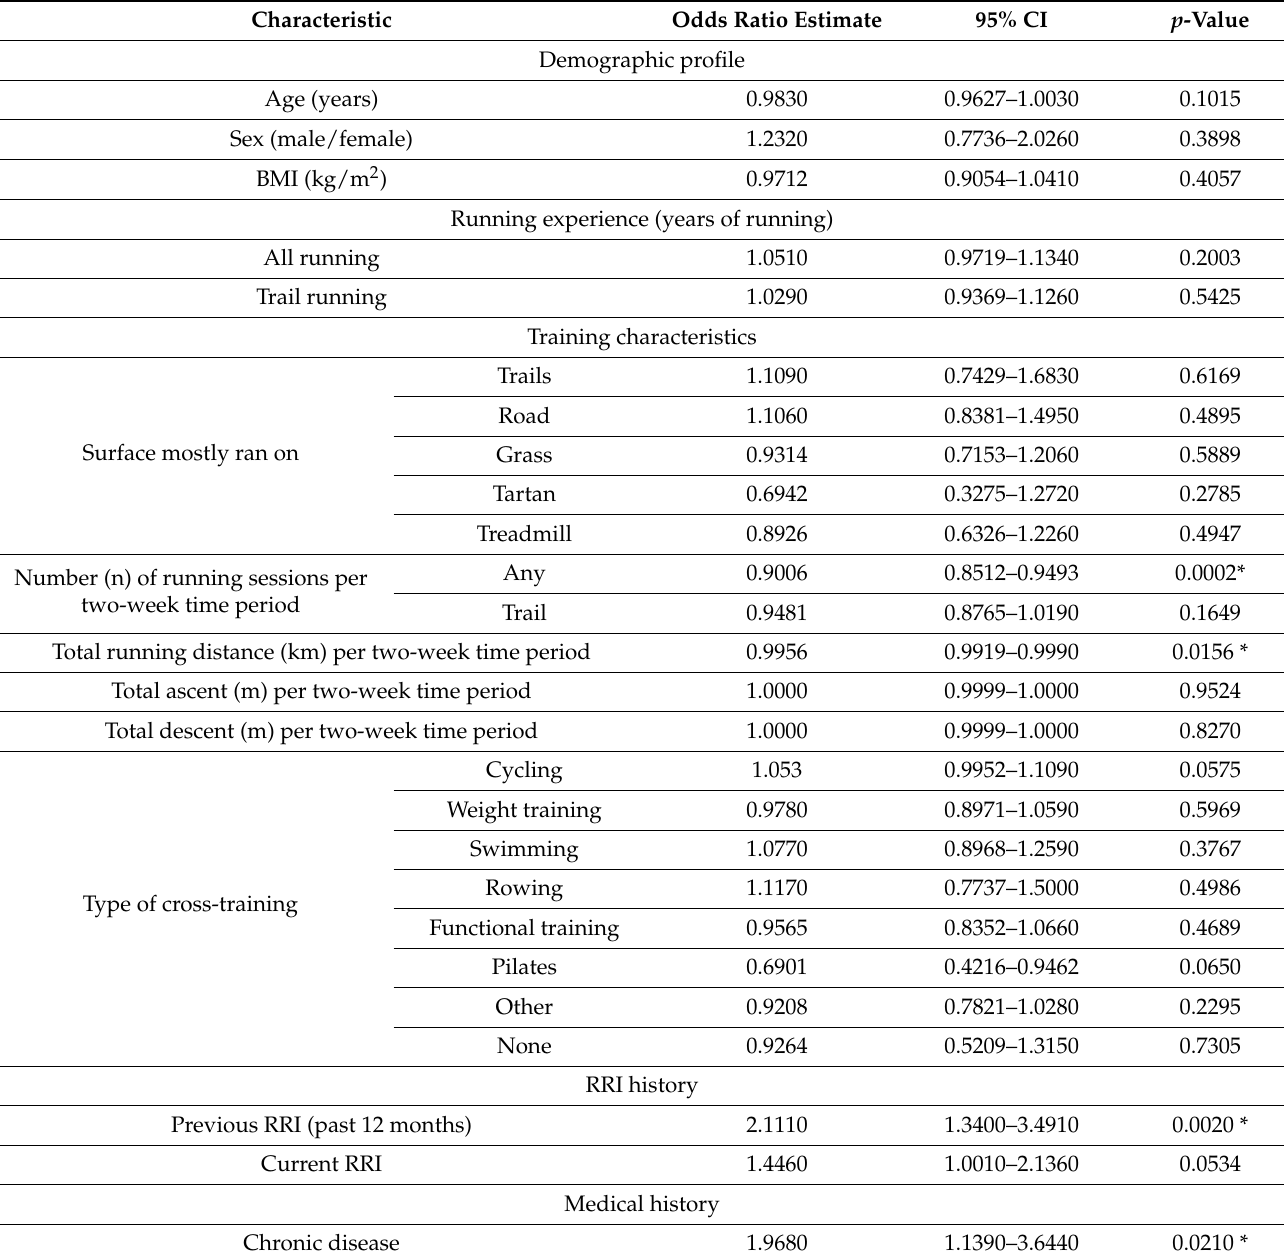
Table 5. The odds ratio estimate (%; 95% CI) and p-value for trail runner race entrants with an RRI according to demographic profile, running experience, training characteristics, RRI history, and medical history (univariate